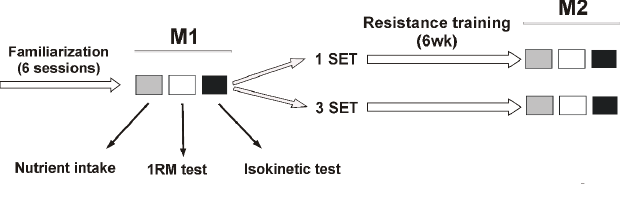
Figure 1. Experimental design.